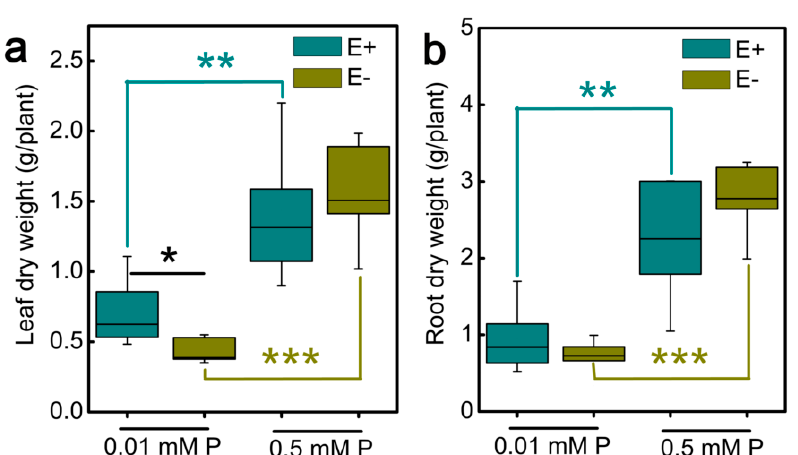
Figure 1. The dry weight of leaves and roots in E − and E+ plants at 0.01 and 0.5 mM P. ( a ) The dry weight of leaves; ( b ) the dry weight of roots. *, ** and *** showed differences at p < 0.05, p < 0.01, and p < 0.001, respectively.